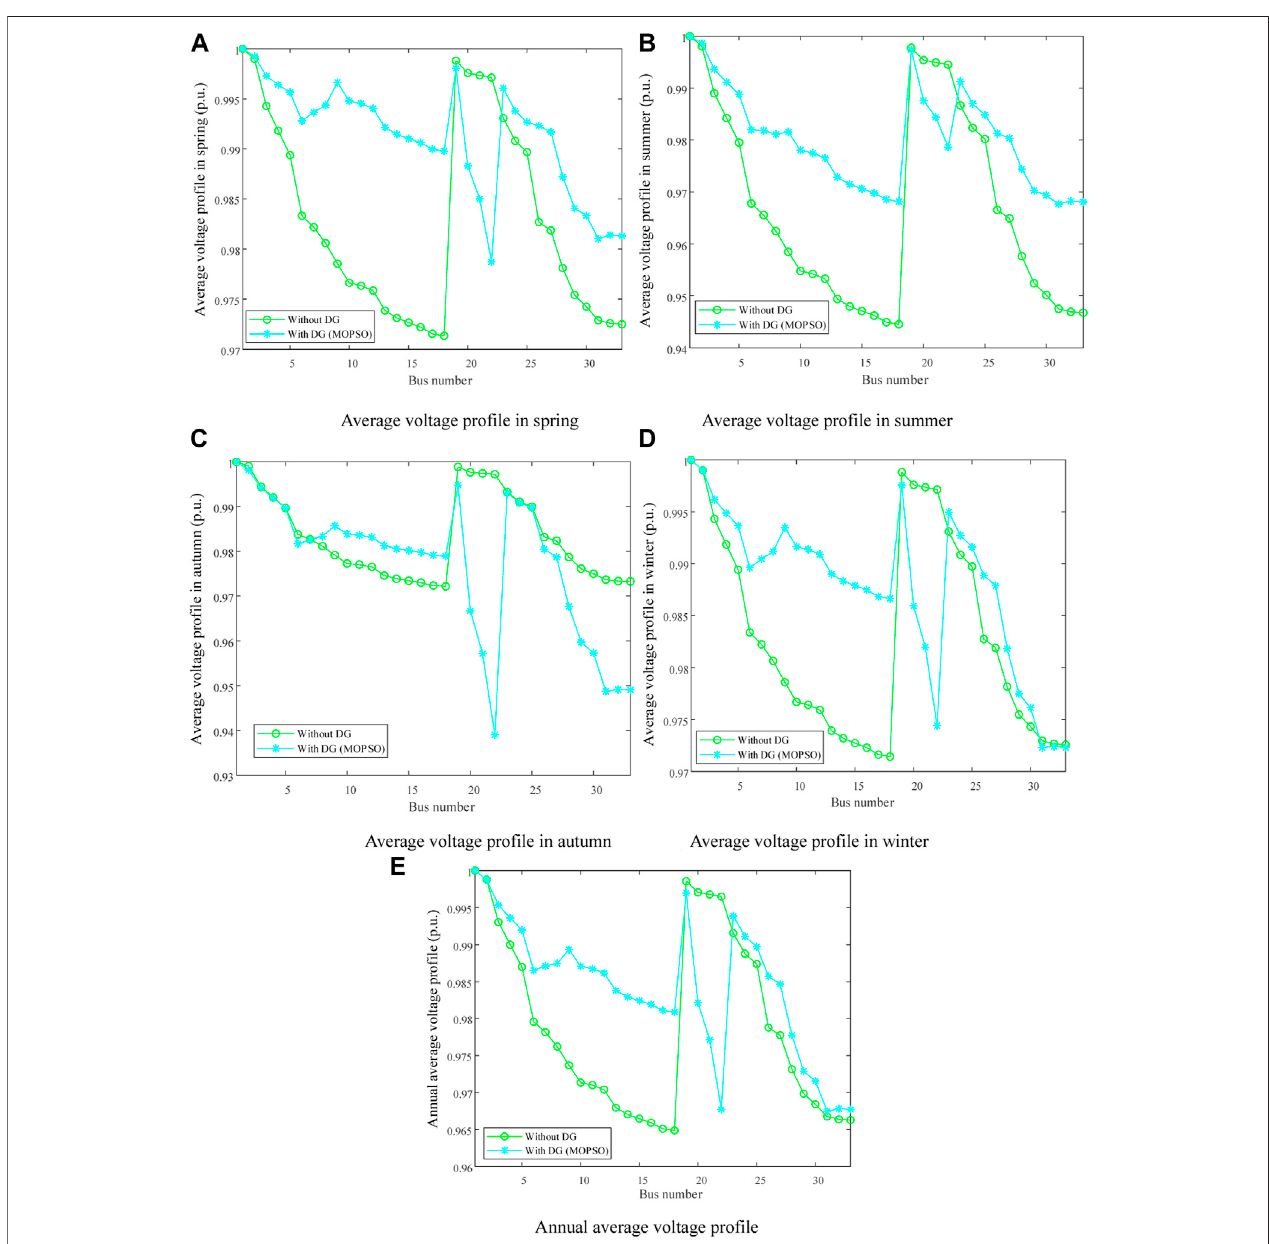
FIGURE 7 | Voltage pro fi le improvement of the IEEE 33-bus distribution network.